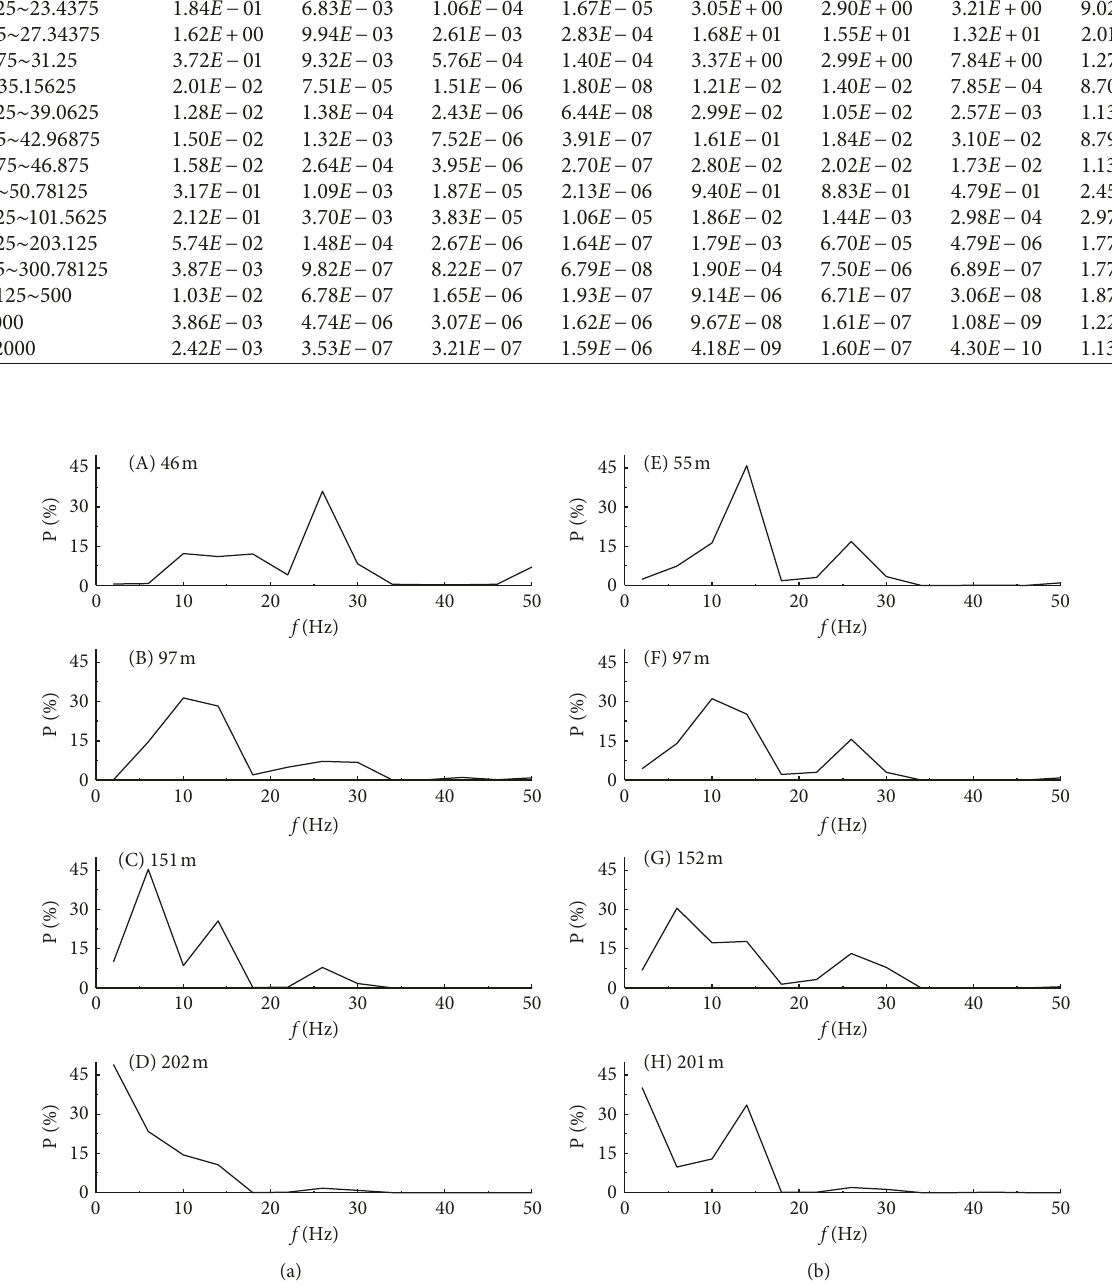
Figure 9: Time-frequency energy spectrum distributions for blast vibration signals. (a) D1. (b)